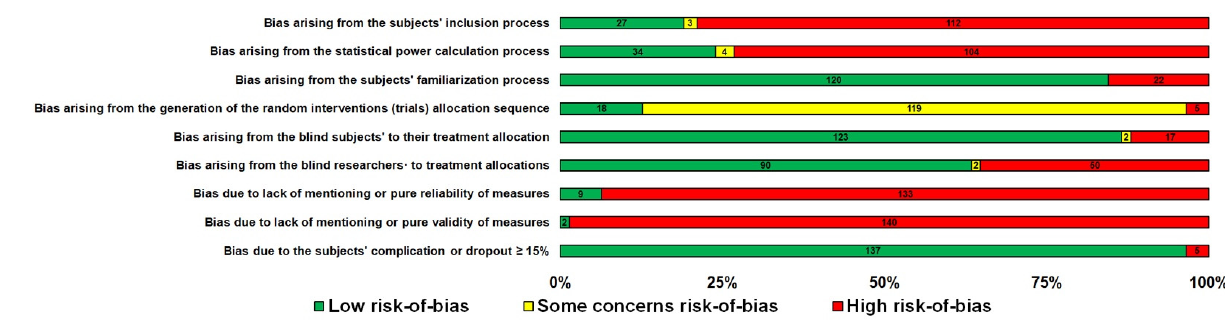
Figure 2. Overview of the authors’ judgments for each risk ‐ of ‐ bias item as a percentage in 142 trials.